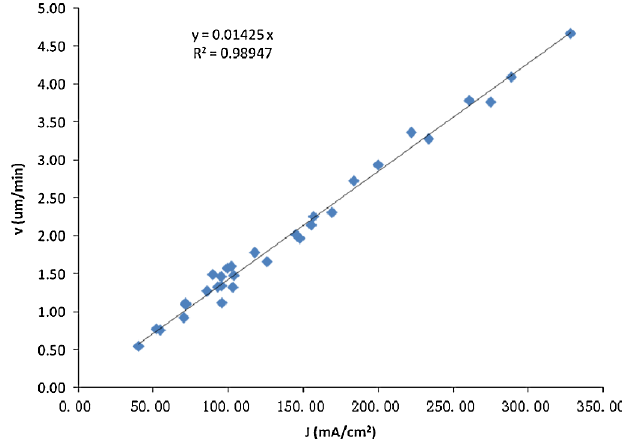
FIG. 7. (Color) The validation of Faraday’s law of electrolysis in